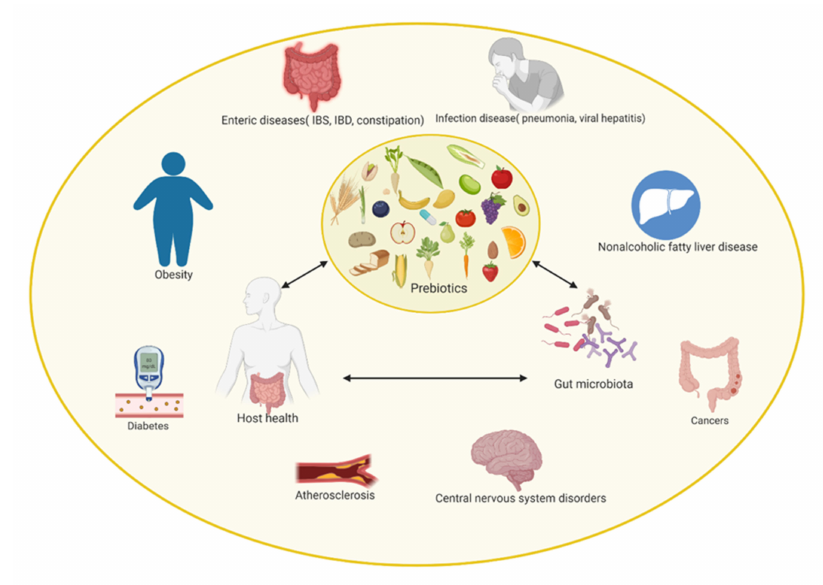
Figure 2. Roles of polyphenols on gut microbiota and implications in human